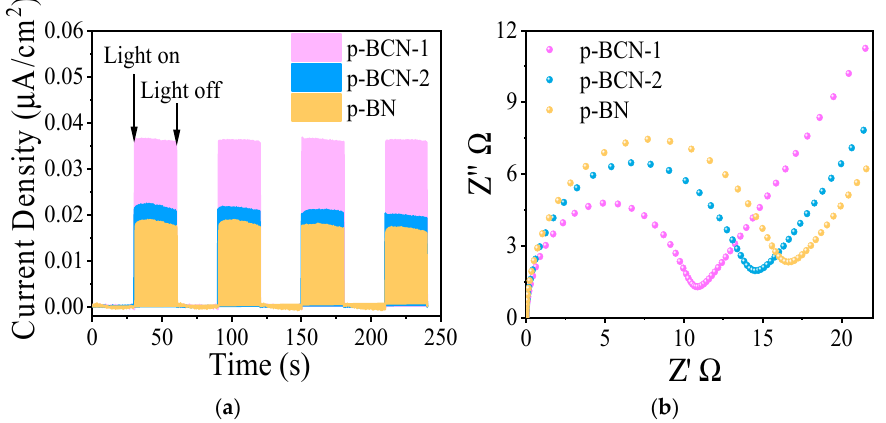
Figure 11. ( a ) Transient photocurrent density responses and ( b ) EIS Nyquist plots of p-BN, p-BCN-1, and p-BCN-2 samples.